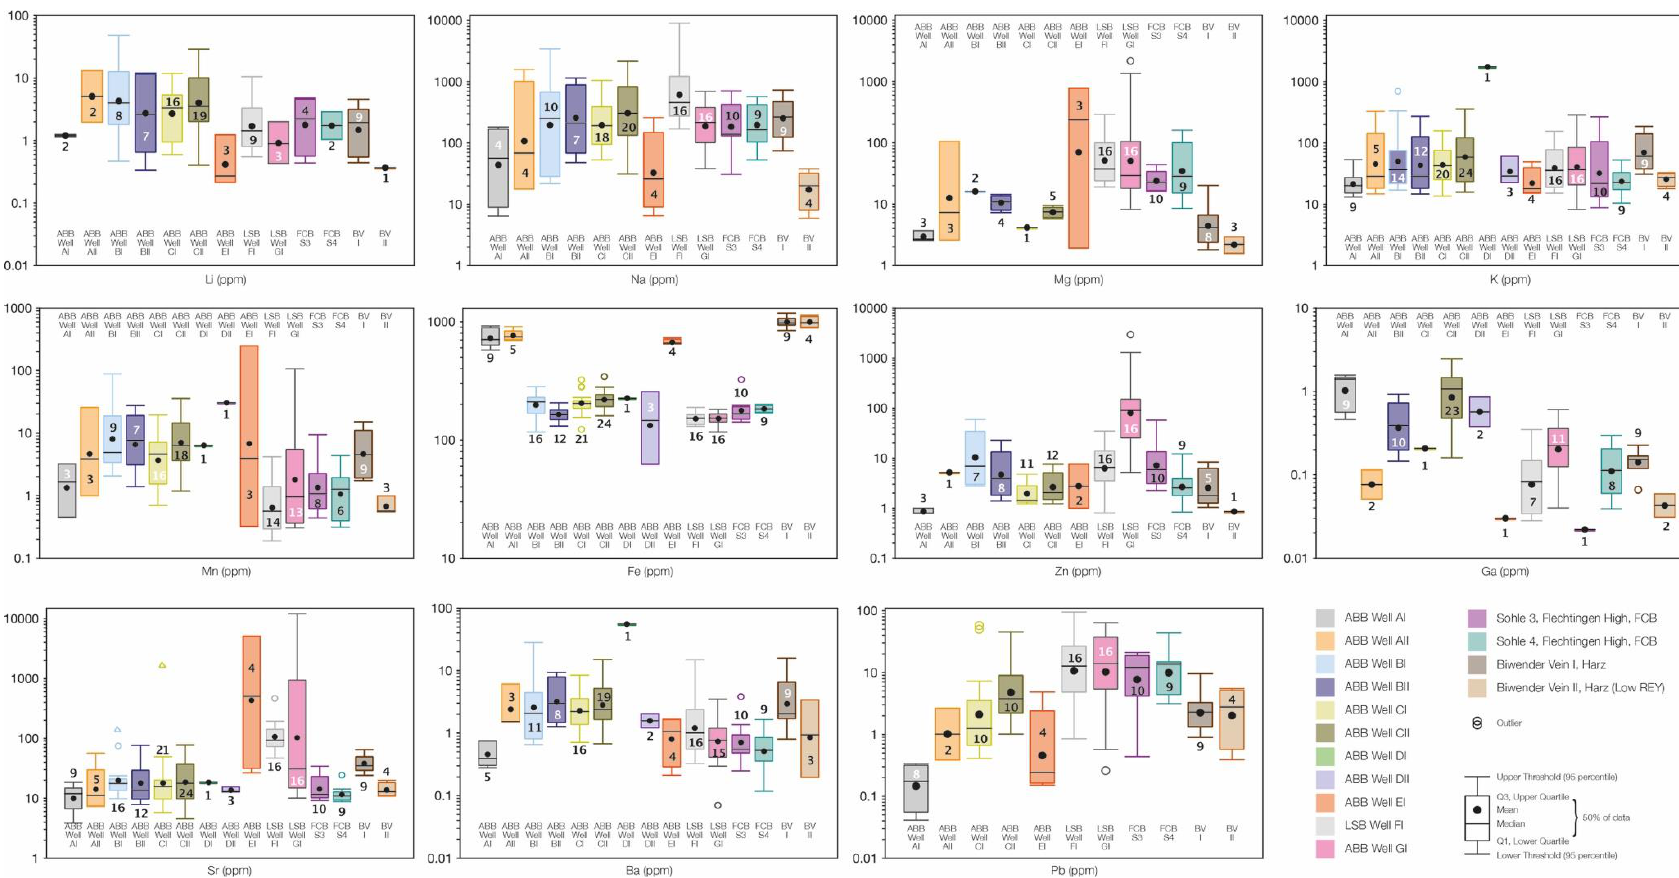
Figure 4. Minor and trace element concentrations (excluding REY) in fluorite from the different investigated localities. Numbers in the boxplots indicate the number of analyses (above the level of detection) the corresponding values are summarized in Table 2. Note that the displayed median and mean values are based on the logged data and may therefore deviate from the data in Table 2 .